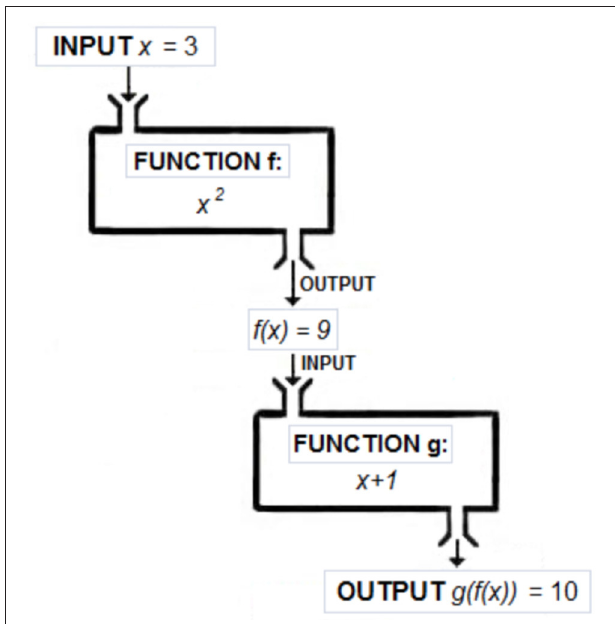
FIGURE 9 | Process of transforming data in a deep learning ELM algorithm. Source: Terry-Jack